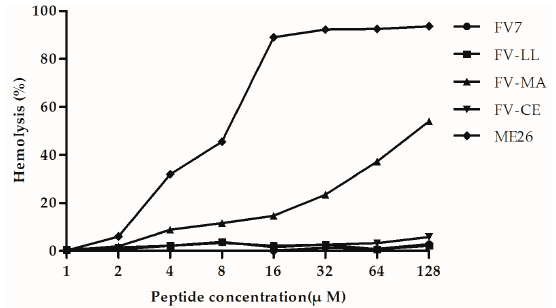
Figure 3. Hemolytic activities of the peptides against fresh human erythrocytes. The release of hemoglobin was monitored with a Microplate Autoreader (SpectraMax M5, Molecular Devices, San Francisco, CA, USA) by measuring the absorbance at 570 nm. Data are the averages of three independent experiments.